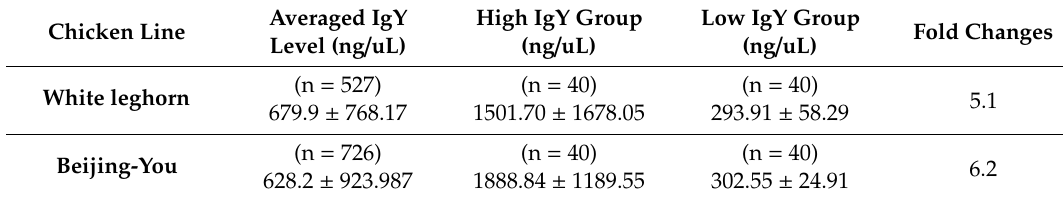
Table 1. Averaged immunoglobulin Y (IgY) levels of selected chicken